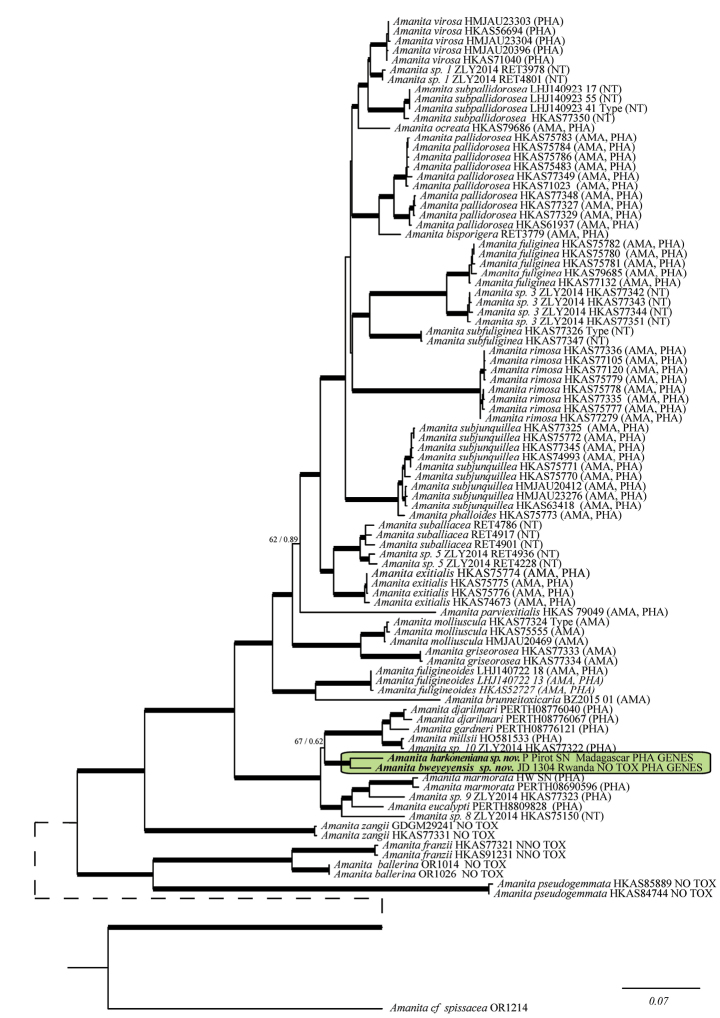
The 50% majority-rule consensus tree from Bayesian inference of the combined dataset. Thickened branches in bold represent ML BS support greater than 75% and BPP greater than 0.95; thickened branches in grey denote branches supported by either ML BS or BPP. For selected nodes ML BS support value and BPP are, respectively, indicated to the left and right of slashes. The new taxa are highlighted in the shaded box. AMA and PHA indicate the presence of amatoxins and phallotoxins, respectively, detected by HPLC. NT indicates not tested.